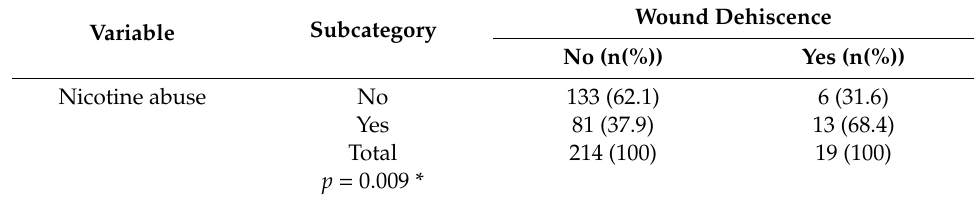
Table 9. Statistical correlation between nicotine abuse and rate of wound dehiscence after osteosynthesis. Variable